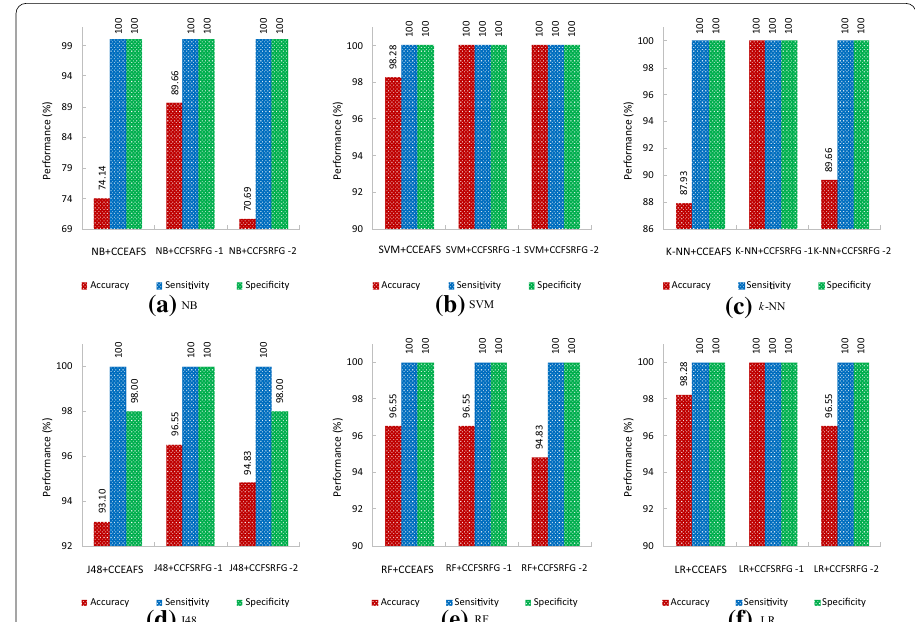
Fig. 10 Performance evaluation of classifiers on the Pulmon Dataset